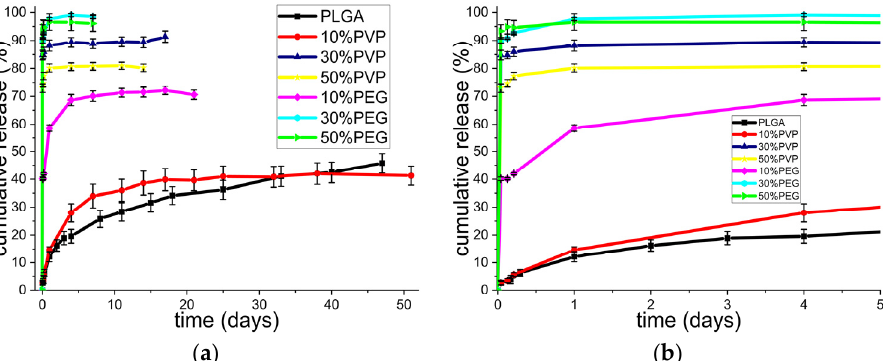
Figure 5. KGN release profiles from PLGA, PLGA/PEG, and PLGA/PVP particles showing ( a ) the full release period and ( b ) an enlargement of the first 5 days. Results are presented as mean ± S.D. from three independent experiments.